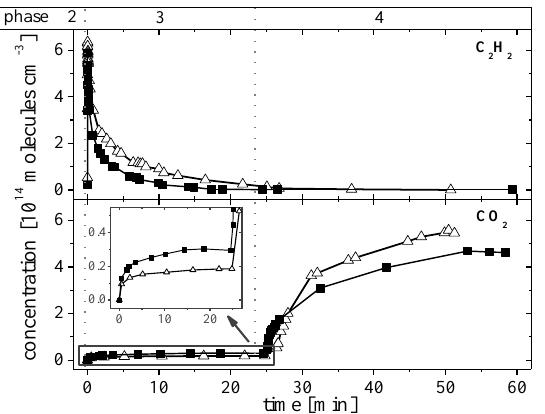
Figure 6. Time evolution of the concentrations of C 2 H 2 (upper panel) and of CO 2 (lower panel) in phases 3 and 4 (initial gas mixture: 1% C 2 H 2 in Ar, p = 2.6 mbar). After-treatment: ∆—heating to 350 °C and ■ —UV radiation exposure [51], © IOP Publishing. Reproduced with permission. All rights reserved.